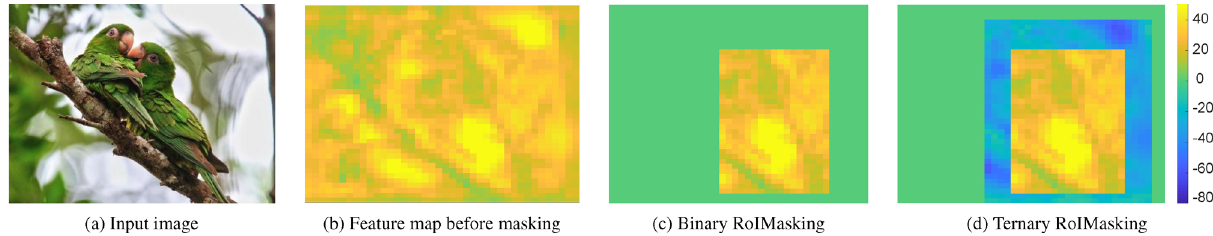
Fig. 4 Output feature maps of two different types of RoIMasking layer. (a) Input image. (b) Before RoIMasking, all values in the feature map are non-negative because of the ReLU layer. (c) After binary RoIMasking, regions outside the proposal are set to zero. (d) Ternary RoIMasking additionally considers a larger area, in which feature values are